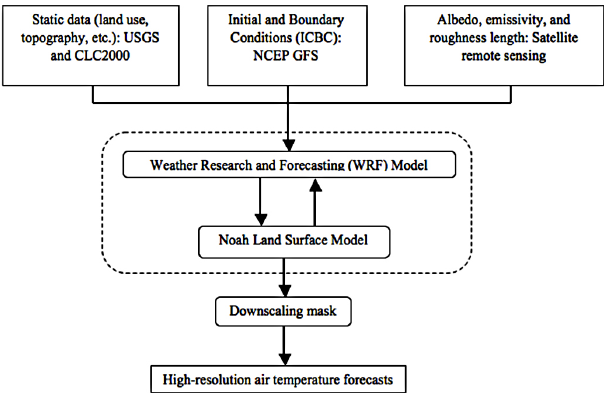
Fig. 2. Flow chart of the urban heat island modeling